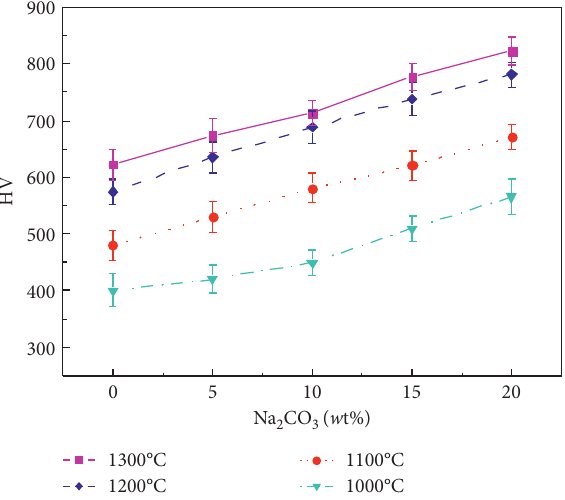
2 CO 3 (b) doping on the density and porosity of solidified body.